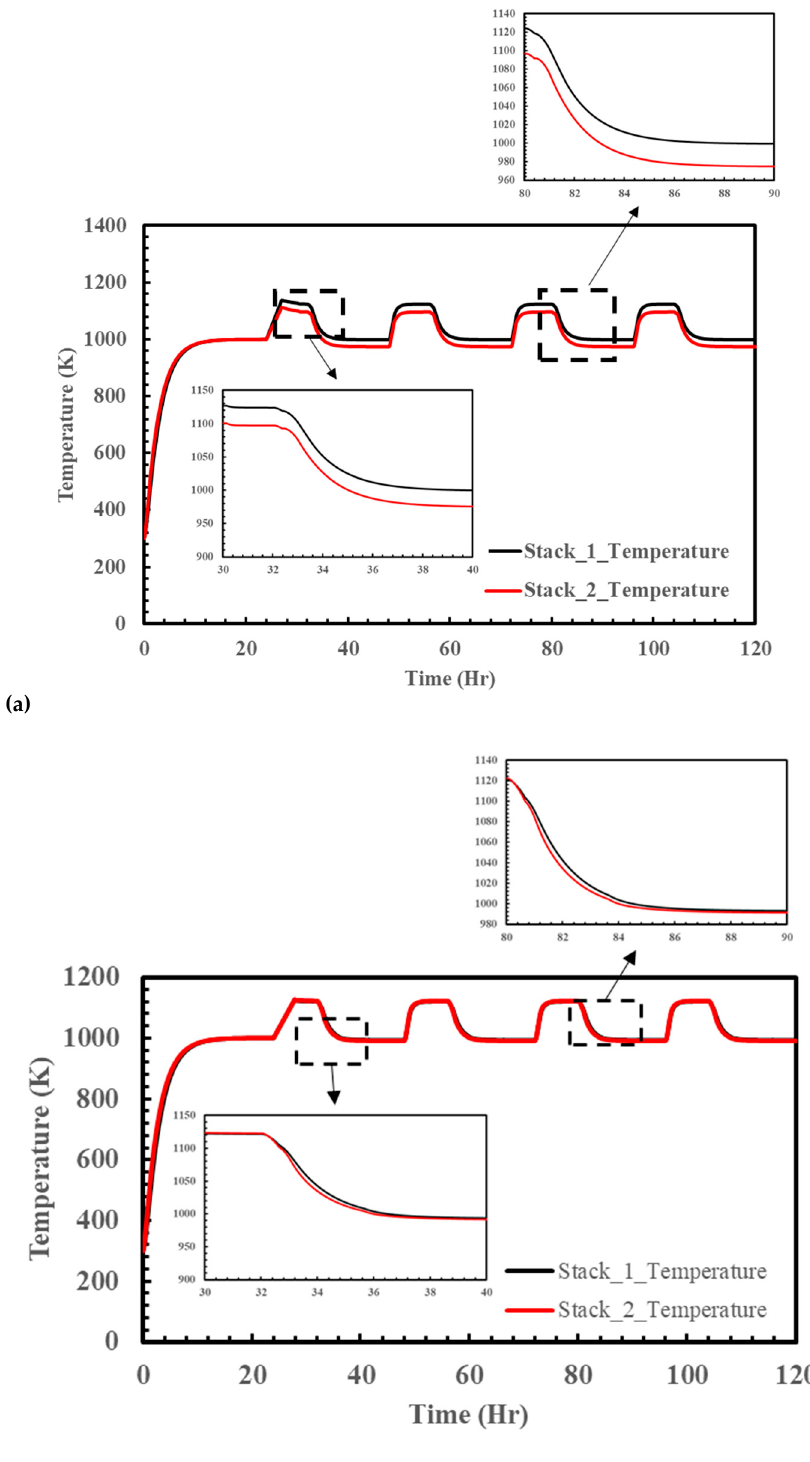
Figure 6. Dynamic curves of stack temperatures in long-term SOFC-CHP system operation. ( a ) The non-modified case; ( b ) optimal control case.